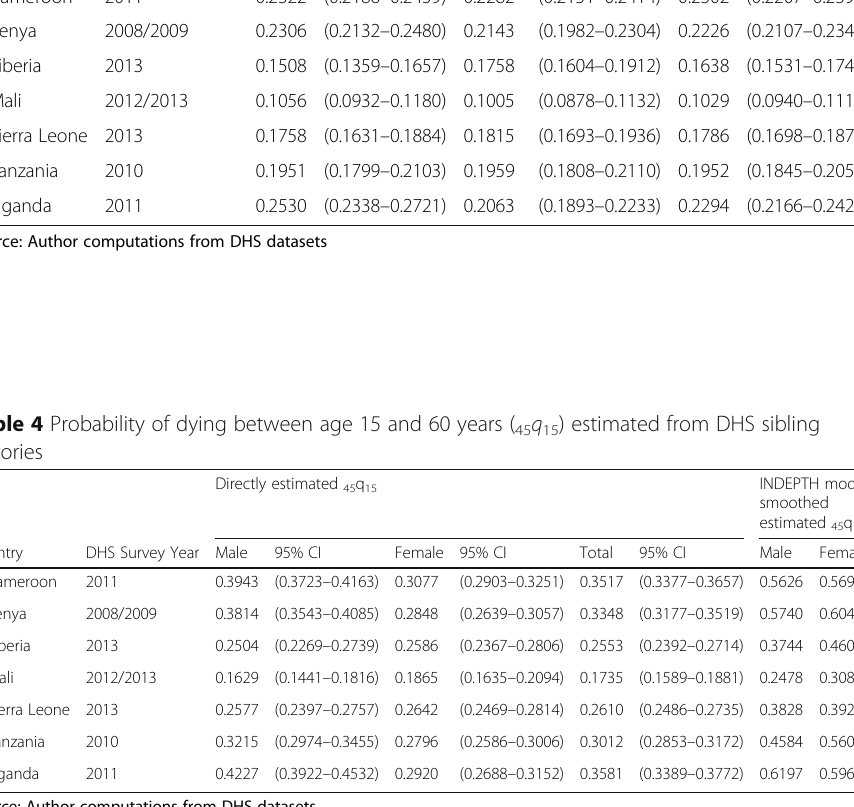
Source: Author computations from DHS datasets *Reference period for the deaths 6 years before the